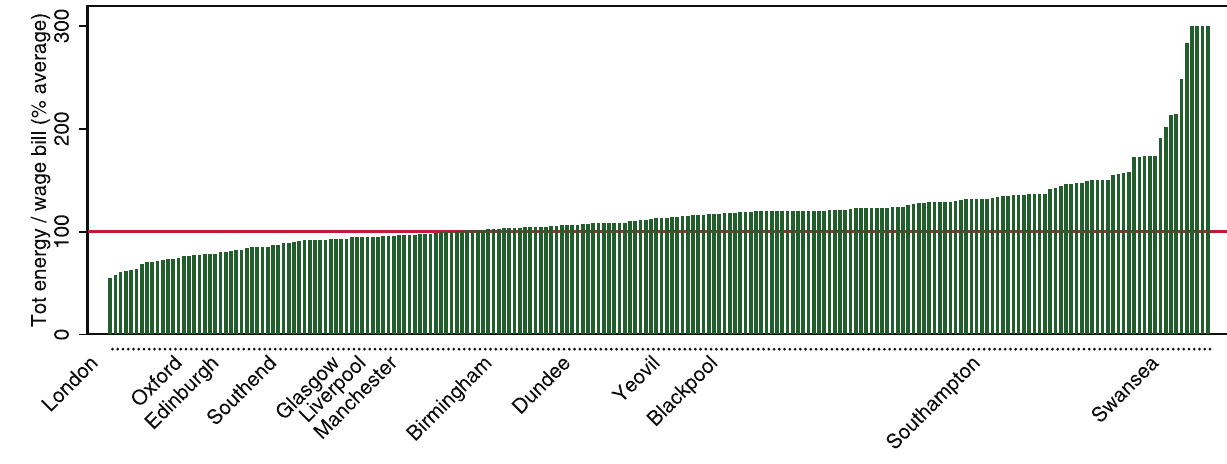
Fig 6. Ranking of cities by energy efficiency. Cities are defined as UK travel to work areas.